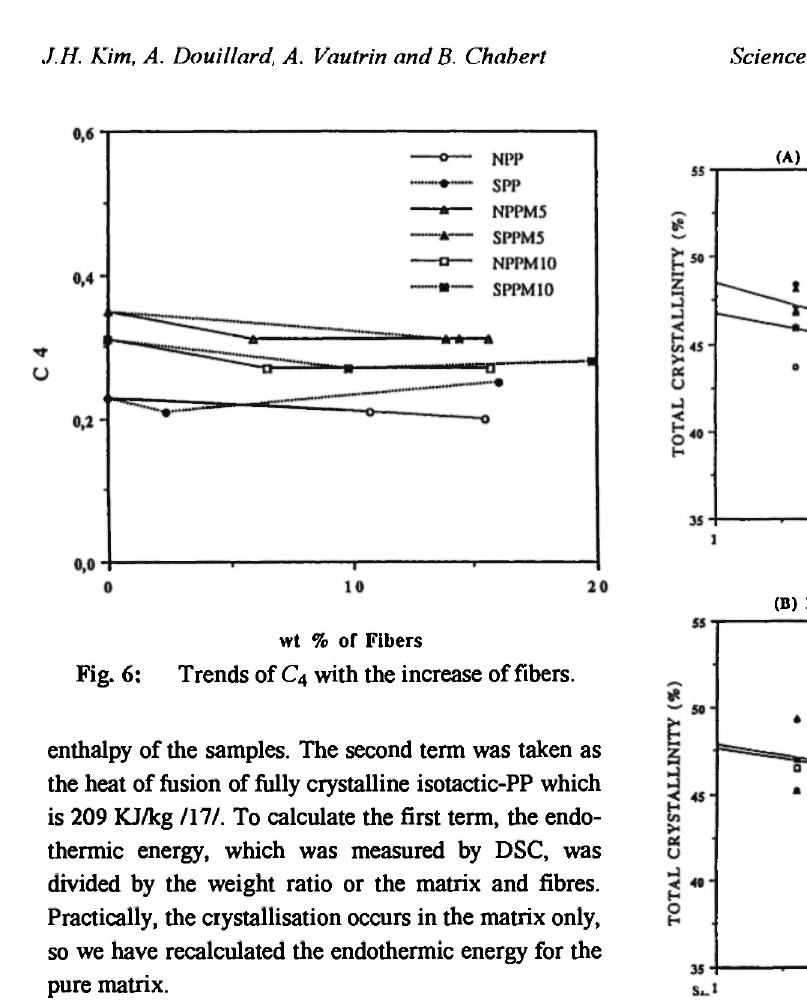
wt % of Fibers Fig. 6: Trends of C with the increase of fibers. 4